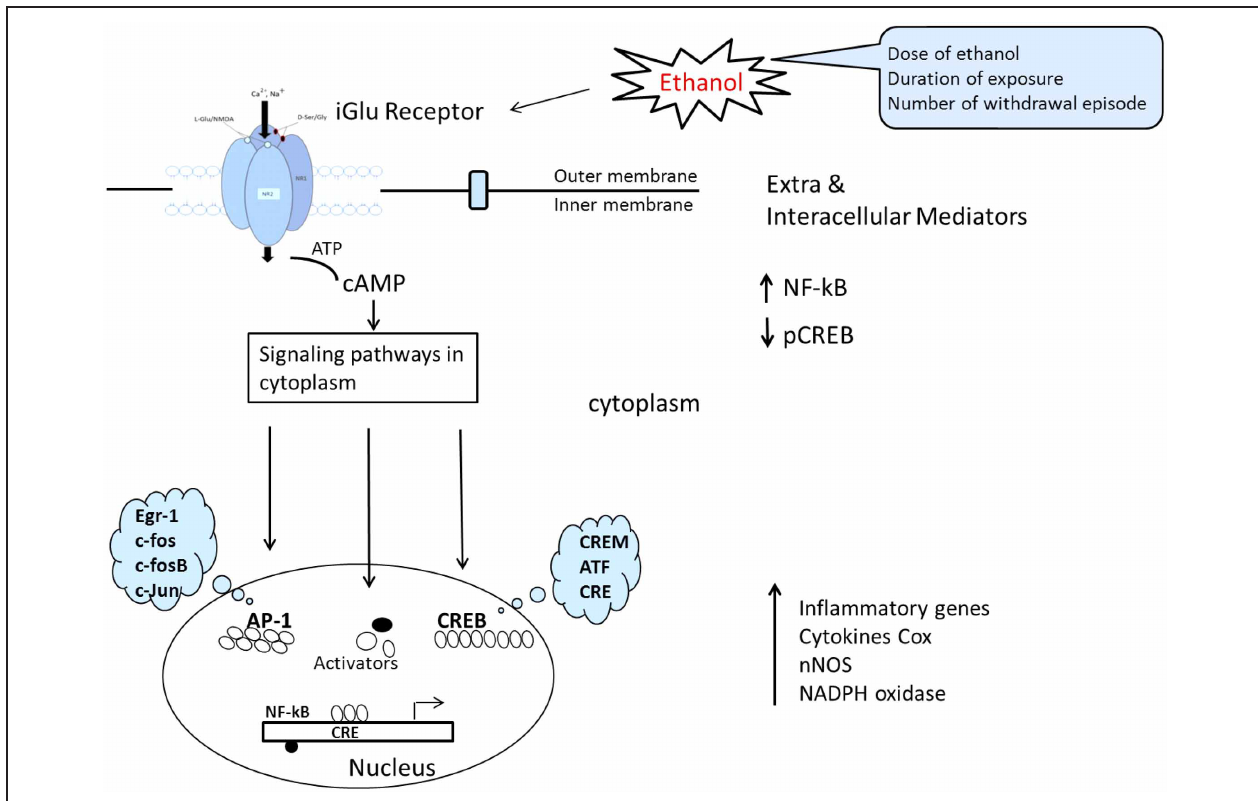
FIGURE 7 | Schematic representation of signal transduction route where by ligands at the cell surface interact with, thereby activate, membrane NMDAR and result in altered gene expression. This converts ATP to cAMP, the convergence of comprehensive signaling transduction in cytoplasm after ethanol influence is directed toward a reduction in CREB